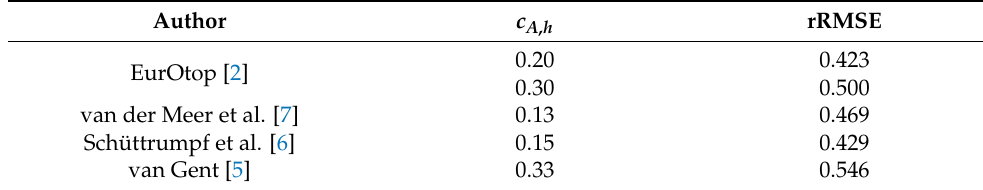
Table 4. Quantitative results on the estimation of OLT at the rear edge breakwater crest using the empirical coefficients and roughness factor available in the previous